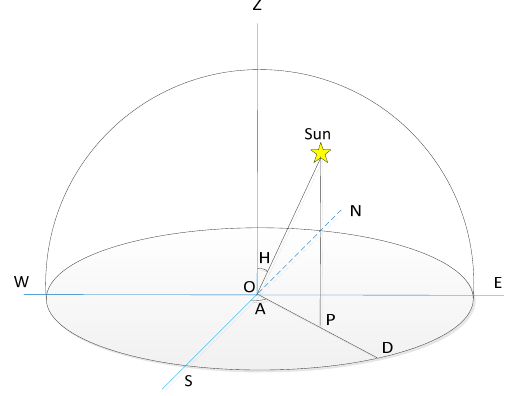
Figure 5. Schematic of fisheye imaging and position of the sun.